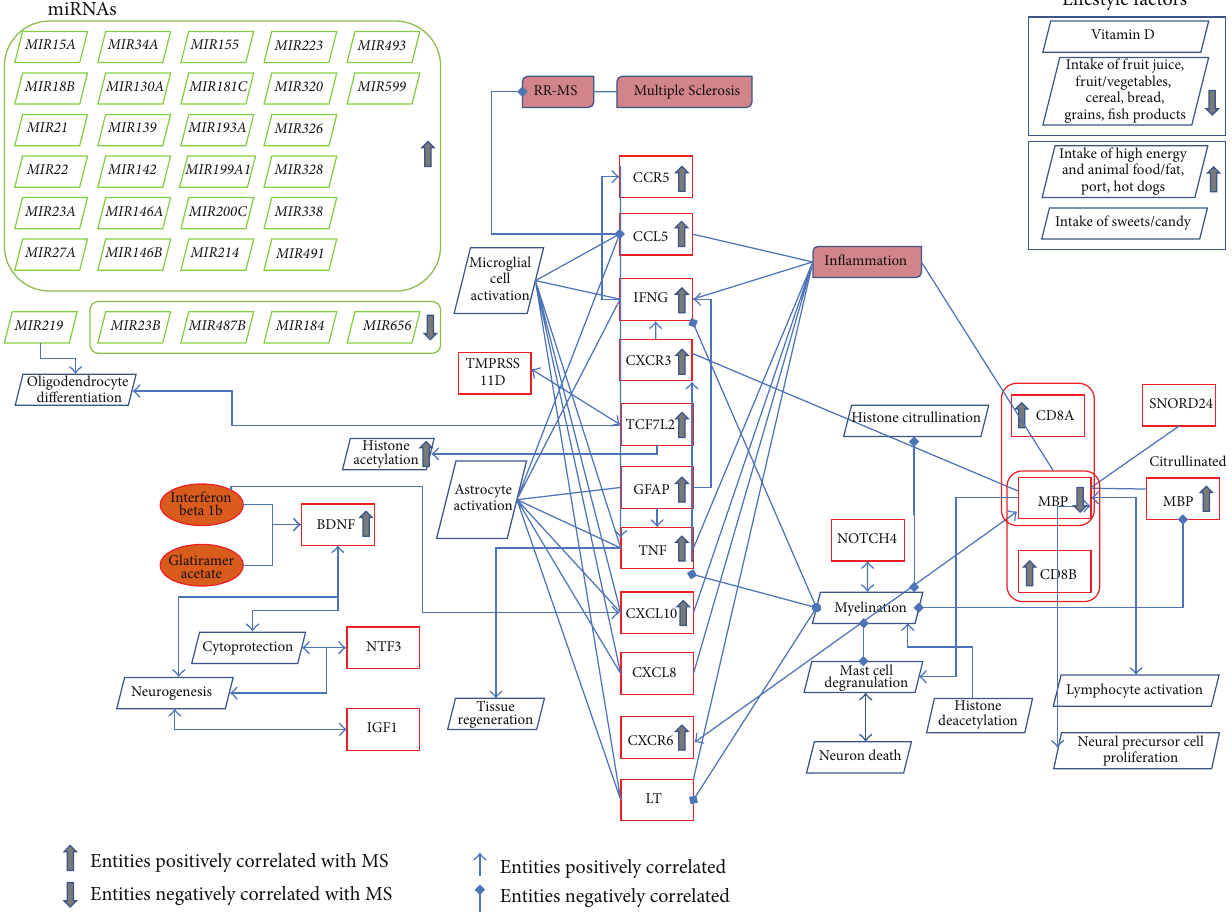
Figure4:ModelaroundepigeneticfactorsinMultipleSclerosis.ThefigureshowsthedifferentepigeneticfactorswhichregulateMSpathology including miRNAs represented in green colour boxes and genes in red colour boxes, chemicals in orange colour, and bioprocess in blue rhombus